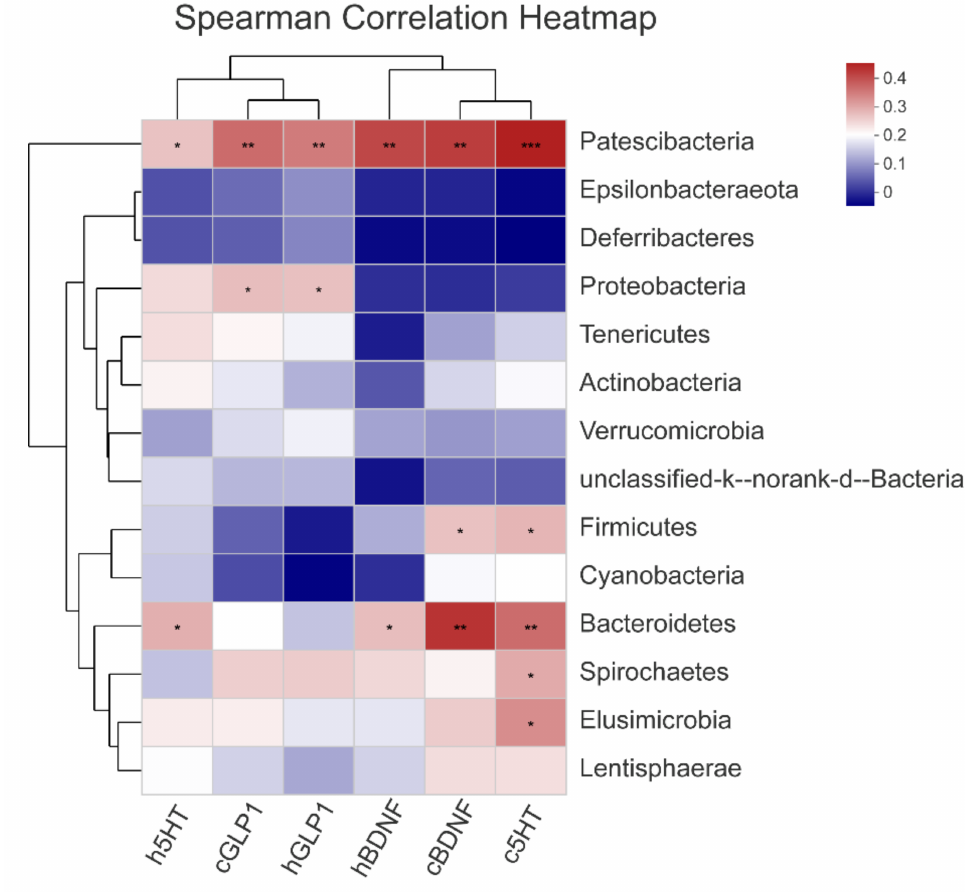
Figure 8. Correlations between the abundances of phyla and neurotransmitters in CUMS rats. The heatmap shows Spearman’s rank correlation between neurotransmitters and the relative abundances of the selected phyla. The most abundant phyla found in rats with at least one more extreme corre- lation than − 0.5 or 0.5 are indicated. The asterisk (*) illustrates the significance of the correlations between neurotransmitters and the relative abundances of the phyla. Hierarchical clustering was pre- sented for both phylum and neurotransmitters based on the Euclidean distances between Spearman’s rank correlations. (* p < 0.05, ** p < 0.01, *** p <